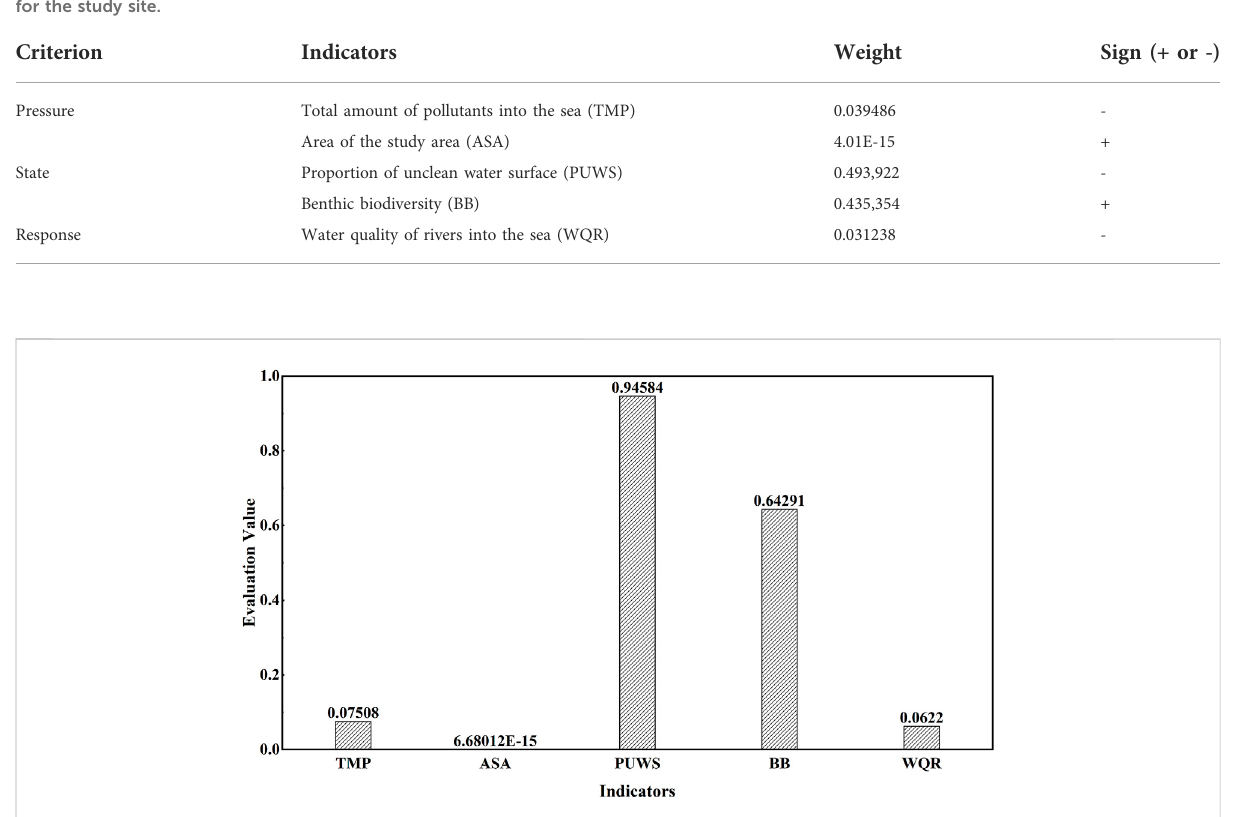
FIGURE 3 Values for indicators considered in the present comprehensive